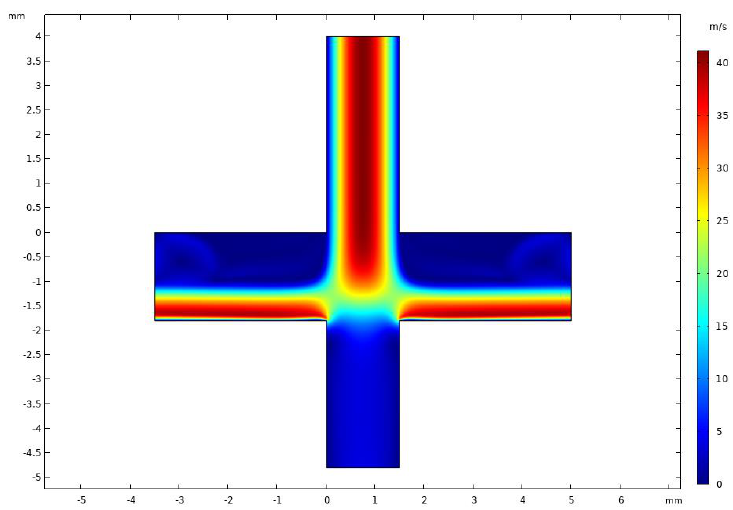
Figure 12. Velocity distribution of VI using CO 2 as fluid.